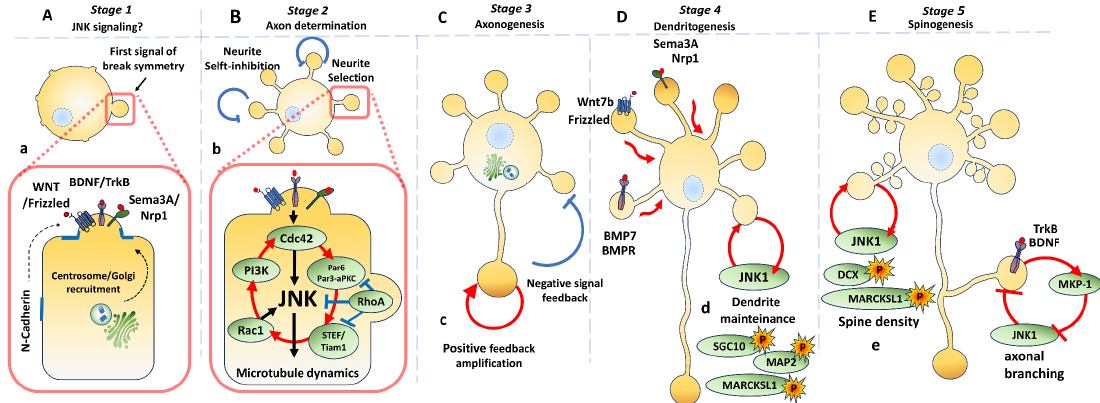
Figure 2. Role of JNKs in neuronal polarization. ( A – E ): Phenotypic changes along neuronal polarization in vitro. ( A ) ( Stage 1) Embryonic hippocampal neurons extend the lamellipodia. Twelve hours later, the breakage of neuron symmetry occurs. ( B ) (Stage 2) Neurons become multipolar. One neurite is selected and experiences a positive feedback signal on its tip, which induces axon determination. ( C ) (Stage 3, axonogenesis) Signal propagates to the soma (red), inducing the stabilization and elongation of microtubules. The remaining neurites receive inhibitory signals (blue) ( D ) ( Stage 4, Dendritogenesis ) After axon elongation, the remaining neurites are extended. ( E ) ( Stage 5, Spinogenesis ) Finally, spines and axonal branching occur. (a–e) Molecular events that occur during neuronal polarization. (a) Axon determination is induced by growth factors. Centrosome and Golgi apparatuses are recruited. (b) Rho GTPases (Cdc42, Rac1) and the Par3 / Par6 / aPKC complex form a positive feedback circuit required for axon determination. (c) The persistent activation of Rac1 and Cdc42 leads to JNK activation, promoting neurite outgrowth through growth cones (red), while the activation of RhoA in minor neurites leads to JNK deactivation (blue). (d) Dendritogenesis is stimulated by BMP7 through Bone Morphogenic Protein Receptor (BMPR), Wnt7b through Frizzled receptor and Sema3A through Nrp1. Dendrite homeostasis is controlled through SCG10, MAP and MARCKSL1 substrates that are activated by JNK1 (red) (e) Spine density is regulated by substrates such as DCX and MARCKSL1, and axonal branching is promoted by the deactivation of JNK1 through